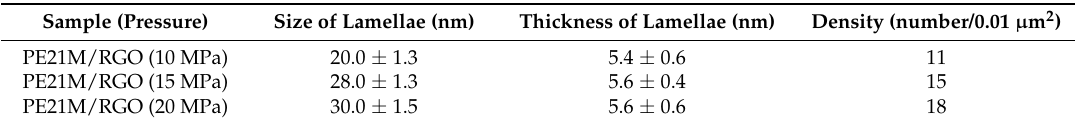
Figure 5. TEM images of PE21M/RGO nanocomposites produced at different SC CO 2 pressures: ( a ) 10 MPa, ( b ) 15 MPa, and ( c ) 20 MPa in p -xylene at 60 ◦ C for 3 h. Table 5. The average size of PE21M lamellae formed on RGO with assistance of SC CO 2 based on the TEM images of 200